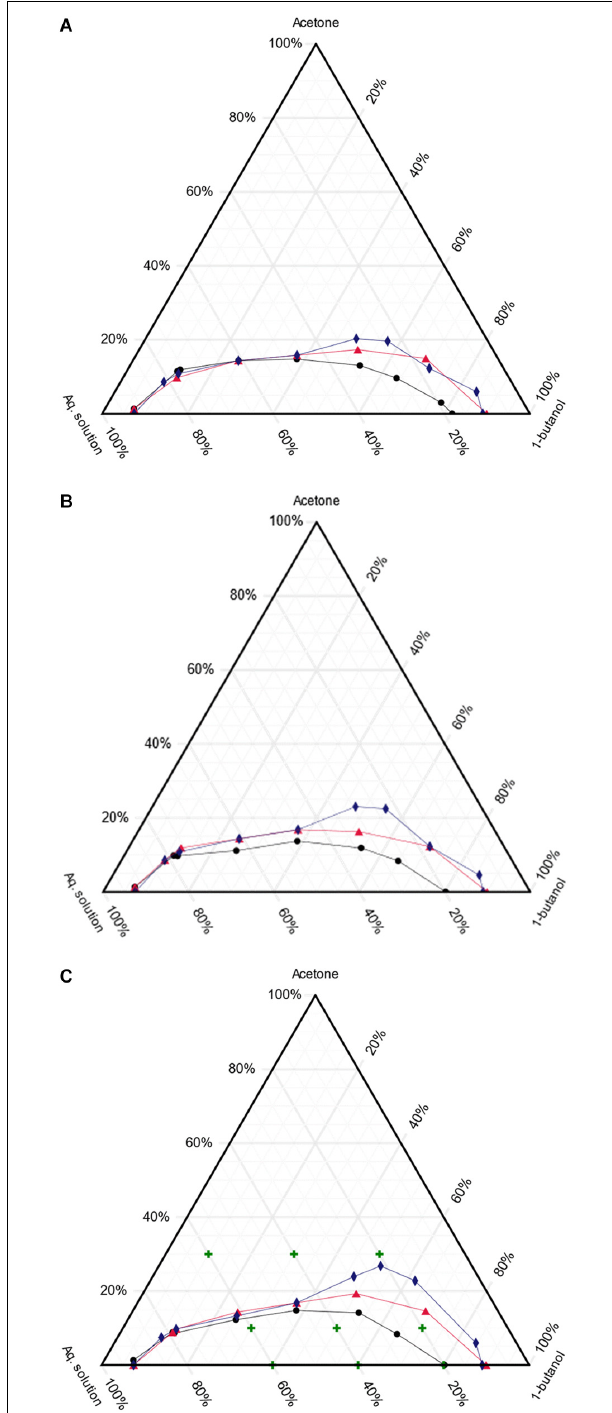
FIGURE 1 | Ternary phase diagram for the acetone/1-butanol/aqueous solution system. (A) , (B) , and (C) correspond to 30, 40, and 50 ◦ C, respectively. Black circles: water; red triangles: 50 mM McIlvaine buffer pH 4.5 and blue diamonds: lactose solution 5 g/L in 50 mM McIlvaine buffer pH4.5. The green crosses in panel (C) correspond to the experimental conditions studied in this work for the synthesis of butyl- β -galactoside. The mixture composition is expressed in mass percentages.